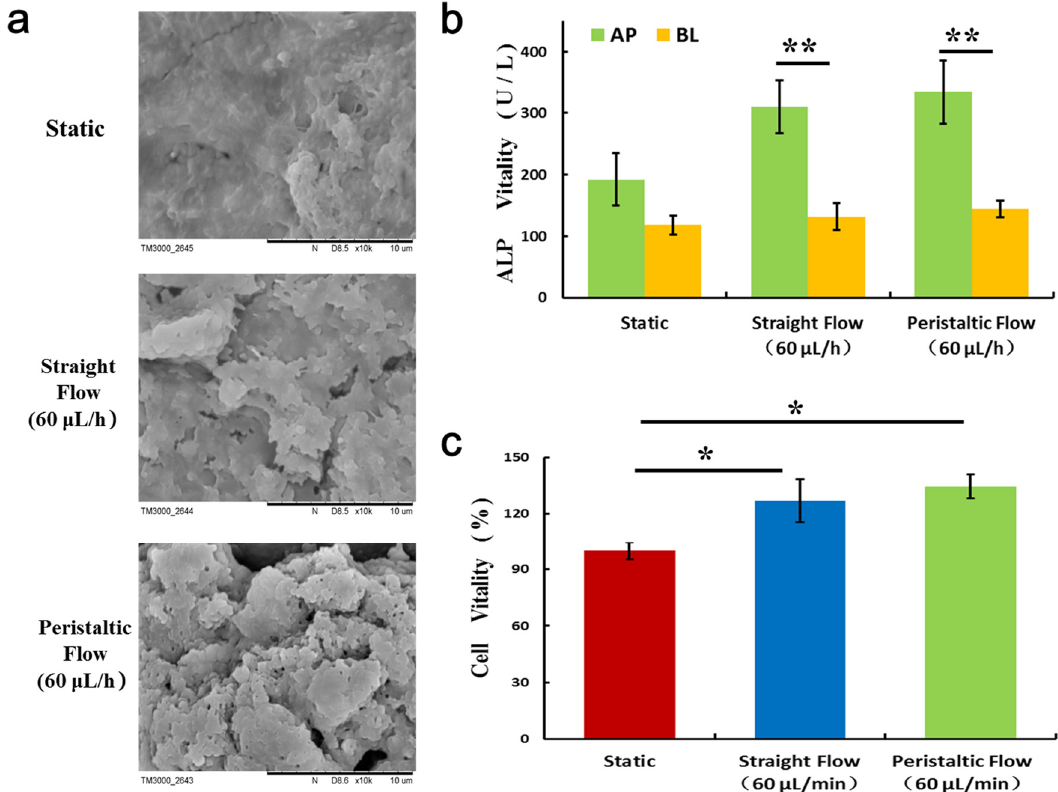
Figure 3. Characterization of intestinal di ff erentiation of the Caco-2 monolayer under di ff erent culture conditions. ( a ) Scanning electron microscope (SEM) images of the morphology of Caco-2 on chip under static, straight flow, and peristaltic flow conditions. ( b ) The ALP vitality of intestinal cells under distinct cultures were assessed on apical (AP) and basolateral (BL) sides, respectively. Results were obtained from triplicate independent experiments (N = 3). Data are shown as mean ± SD. ** p < 0.01. ( c ) Quantified analysis of the Caco-2 cell viability by cell counting kit-8 (CCK-8) kit. N = 3, * p < 0.05.